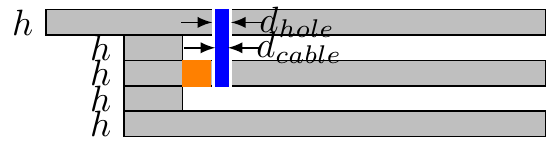
Figure 1. Longitudinal section of the through-wire transition (orange color represents non-metallized parts, blue color represents the metallic wire, the walls of the holes in top and middle layers are metallized with electrodeposition). The wire is tin soldered to top and middle layers.